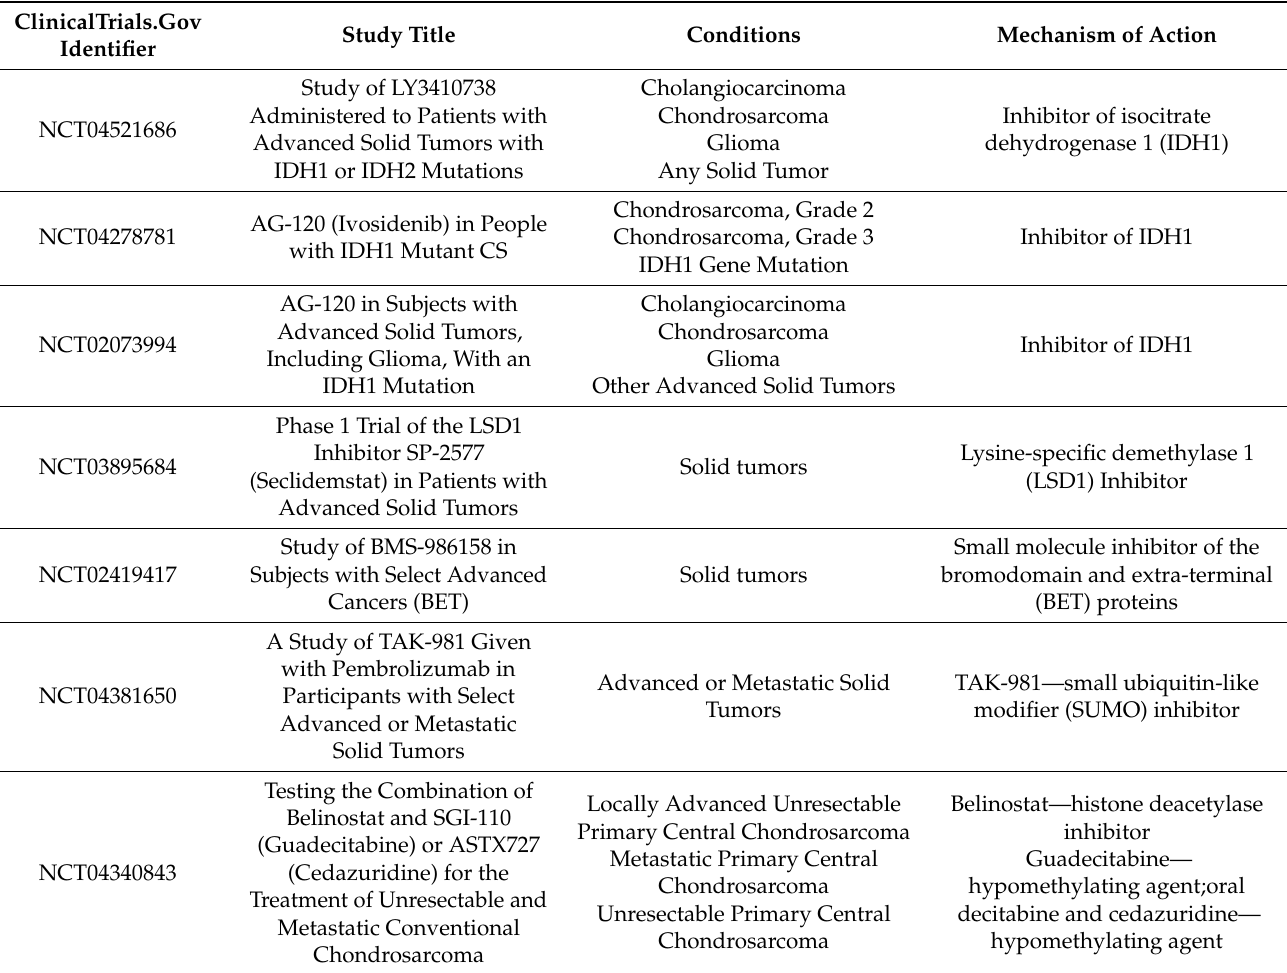
Table 2. Ongoing clinical trials for chondrosarcoma (https://clinicaltrials.gov, accessed on 22 Decem- ber